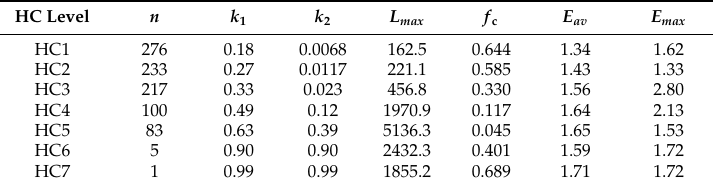
Table 2. Average value of each feature of different hydrophobicity class